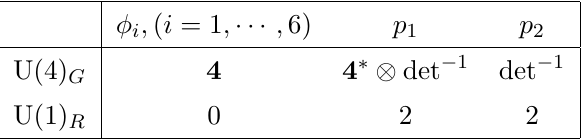
Table 7 . Field contents of U(4) GLSM for X 4 ; 6